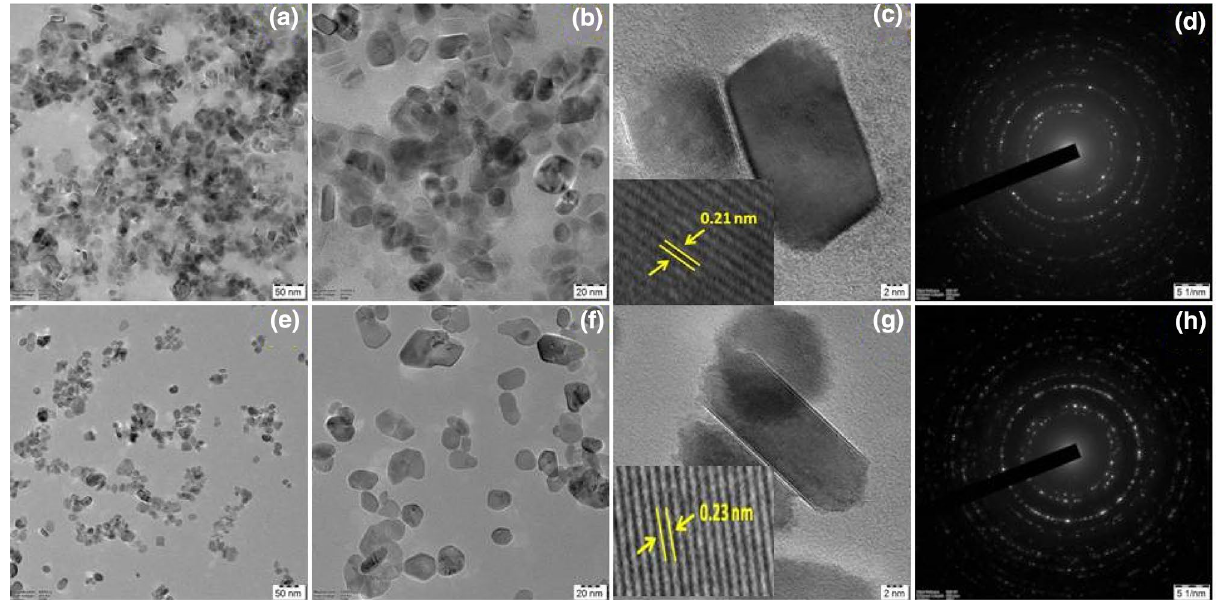
Figure 4. HR-TEM analysis of ( a – c ) NiO NPs and ( e – g ) Mo doped NiO NPs; SAED pattern of ( d ) NiO NPs and ( h ) Mo doped NiO